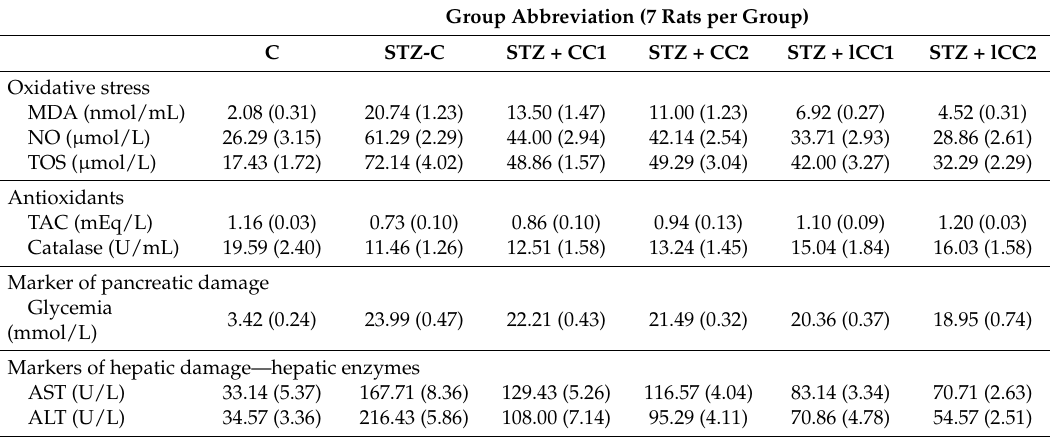
Table 1. Variability in oxidative stress, antioxidants, the marker of pancreatic damage, hepatic enzymes and matrix metalloproteinases by groups expressed as mean and standard